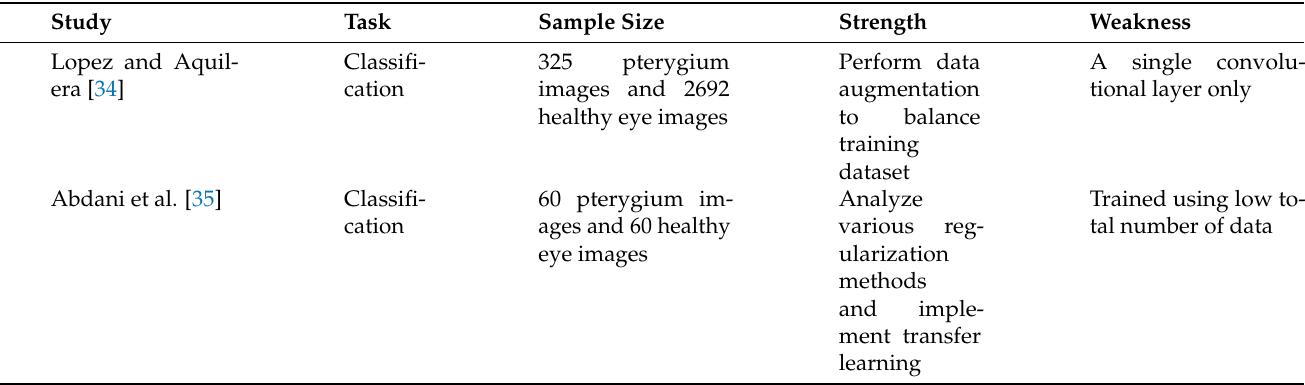
Table 4. Summary of automated pterygium screening systems using deep learning